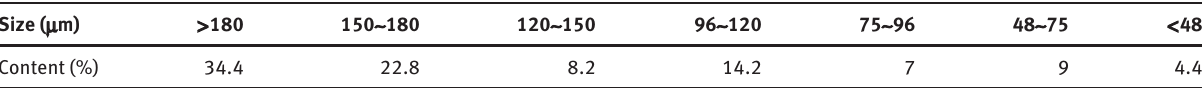
Table 2: Size composition of high titanium